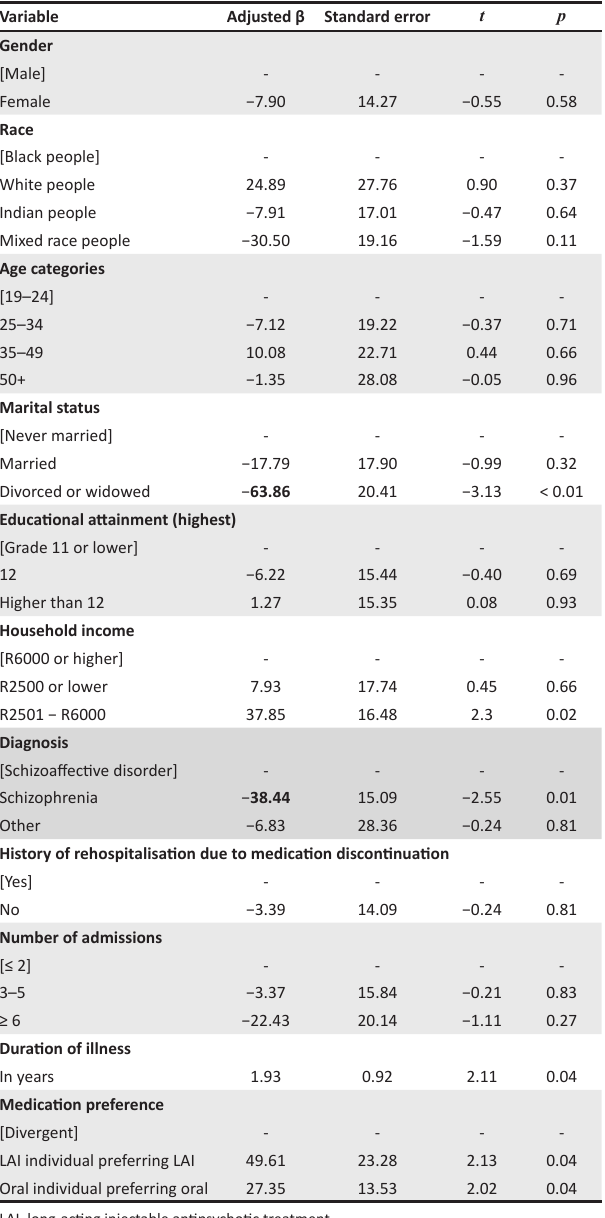
TABLE 3: Association between medication preference and Drug Attitude Inventory scale score using regression model.